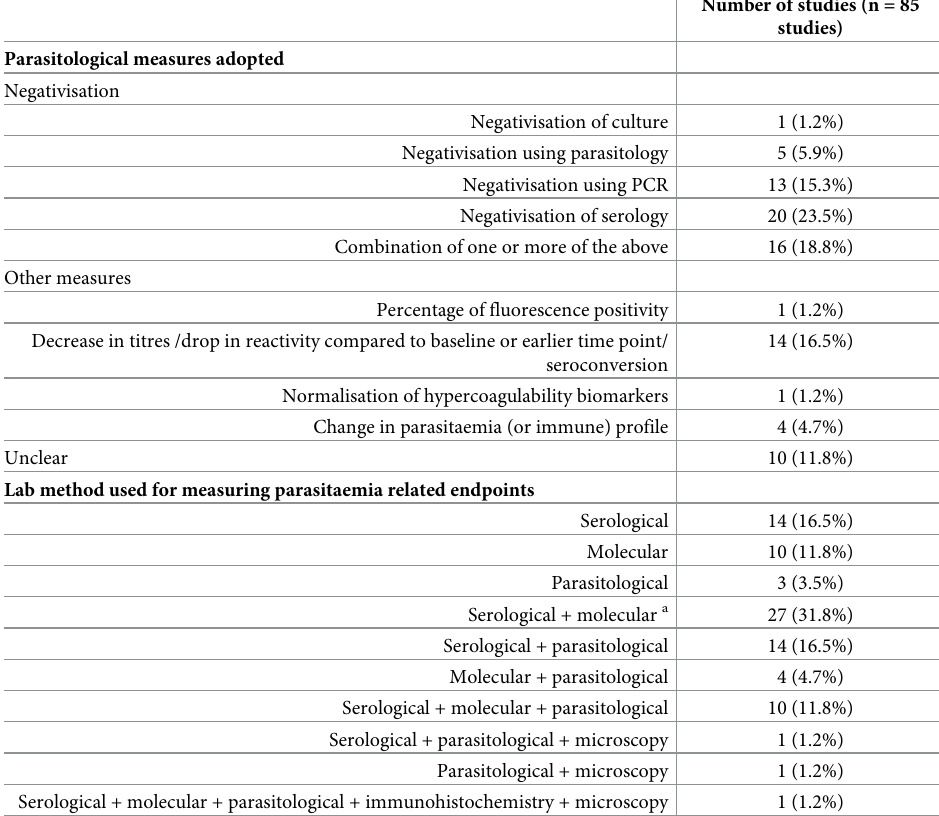
Table 3. Parasitological outcome measures adopted and lab method used for measuring parasitaemia related endpoints.